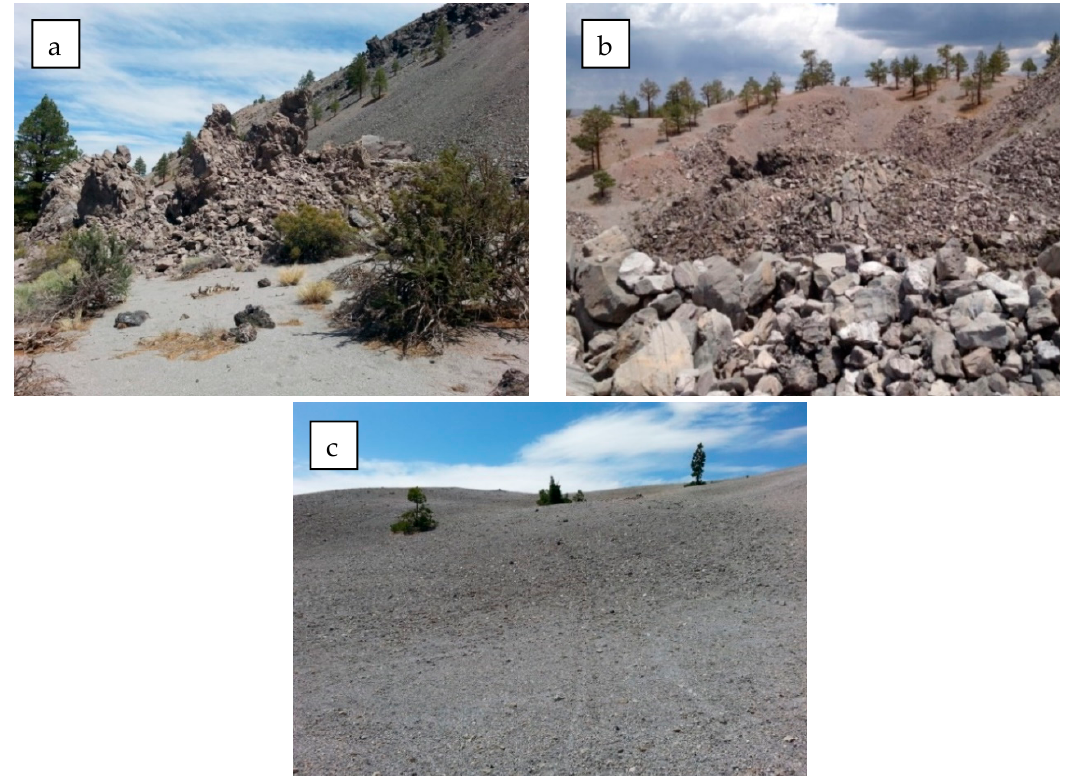
Figure 2. Photographs of the sampling areas investigated during the field campaign: ( a ) slope of the coulee flow front, ( b ) “the Bowl” photogrammetry site, and ( c ) a fine-grained deposit location. These sites demonstrate the range of particle sizes present on the surface of the North Coulee with both mixed and pure end-member samples.